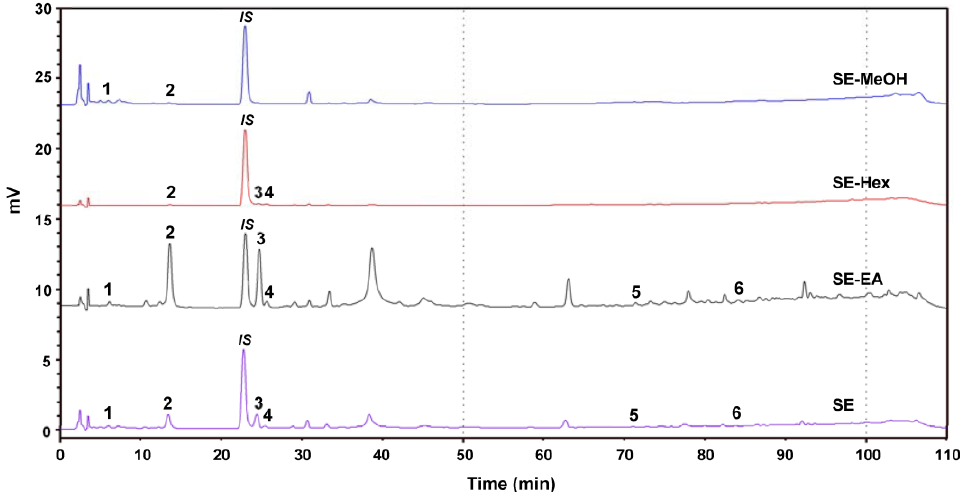
Figure 9. High performance liquid chromatography (HPLC) chromatogram of the four extracts of S. orientalis . Identified components: 1, chlorogenic acid; 2, syringic acid; 3, p -coumaric acid; 4, syringaldehyde; 5, luteolin; 6, apigenin. The peak denoted as “IS” is the internal standard.